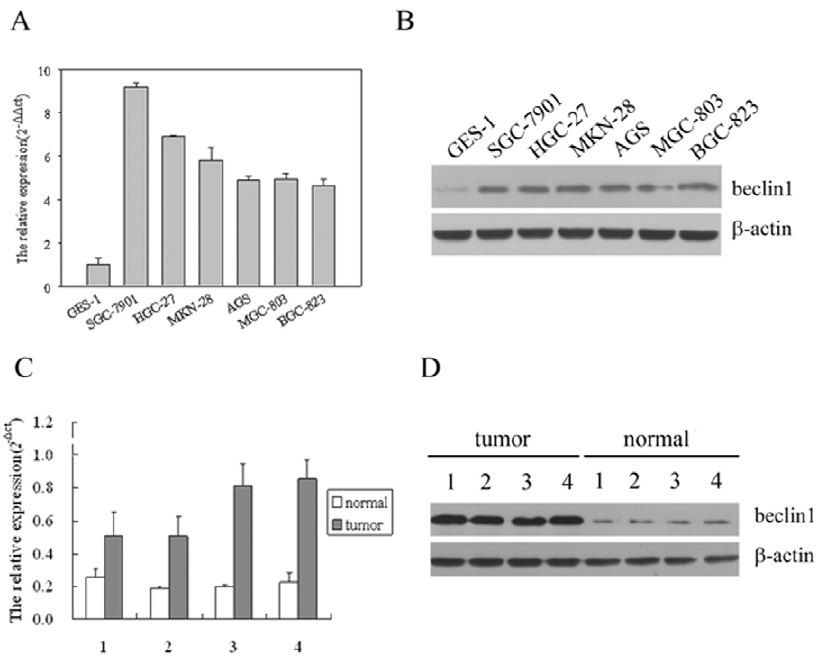
Figure 1. Expression of Beclin 1 mRNA and protein in cells and tissues. (A) Beclin 1 mRNA expression level up-regulated in gastric cancer cell lines compared with normal gastric epithelial cells by reverse transcription-PCR. (B) Beclin 1 protein expression level up-regulated in gastric cancer cell lines compared with normal gastric epithelial cells by western blotting. (C) Beclin 1 mRNA expression is elevated in primary gastric tumors compared with paired gastric adjacent noncancerous tissues by reverse transcription-PCR. (D) Beclin 1 protein expression is elevated in primary gastric tumors compared with paired gastric adjacent noncancerous tissues by western blotting.